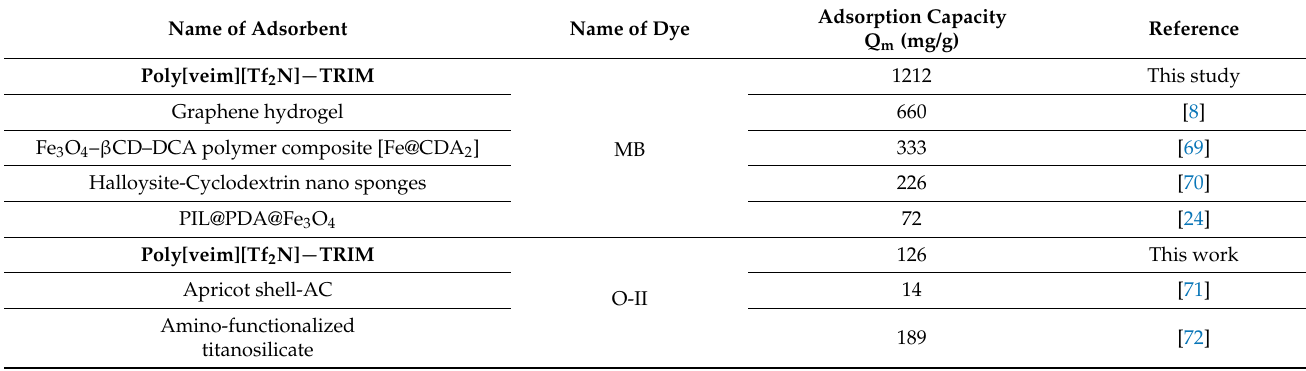
Table 3. A relative comparison of adsorption efficiency of various adsorbents for the removal of MB and O-II